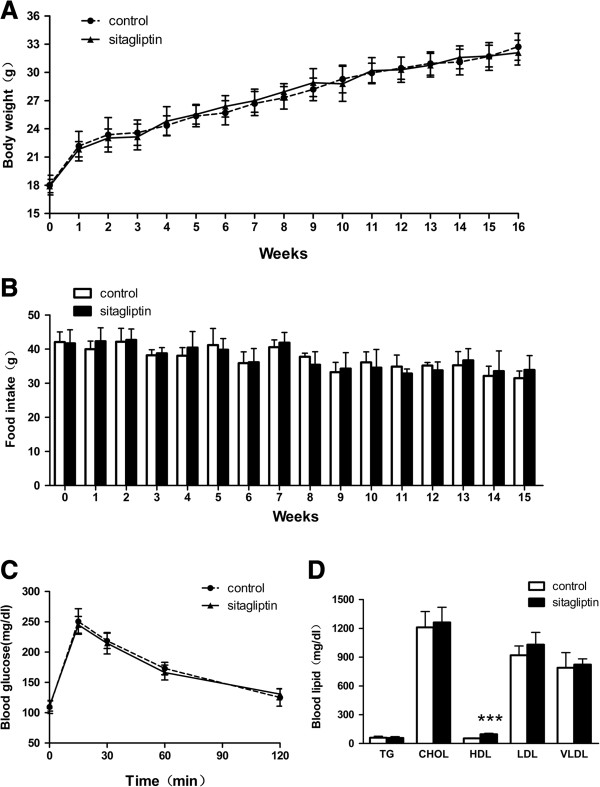
Characteristics of control mice and those fed sitagliptin. There were no significant differences in body weight (A), food intake (B), blood glucose (C), or blood lipids (D) between the two groups, except for a significantly increased HDL cholesterol level in mice in the sitagliptin group. Data are mean ± SD, n = 12 per group.